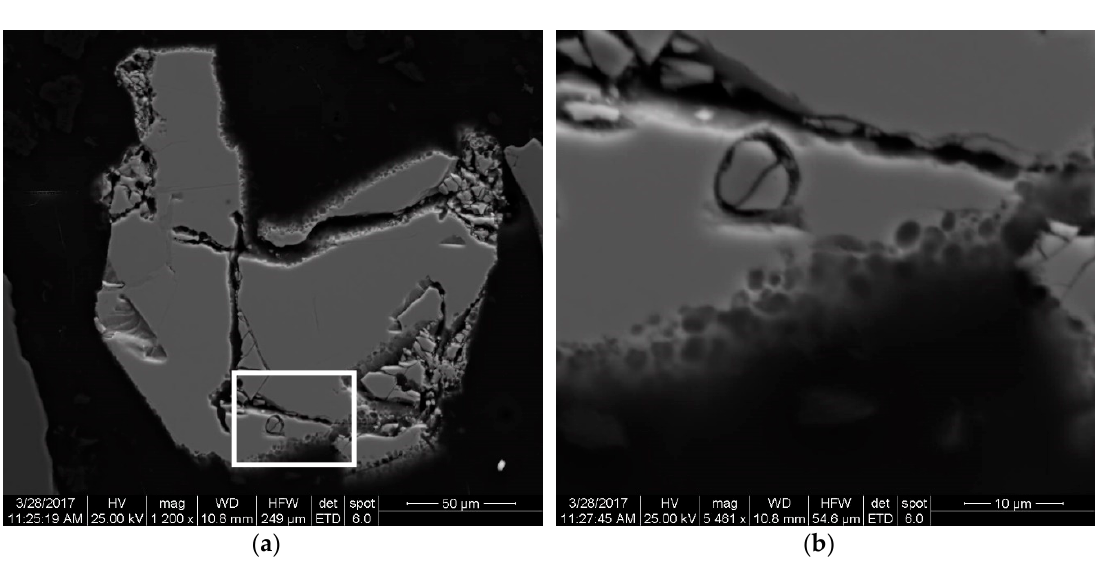
Figure 15. ( a ) Pentlandite grain showing pitting of the mineral surface and along cracks in the mineral grain. Secondary electron image: nitric acid treated concentrate. ( b ) Enlargement of area outlined in ( a ). Notice the pitted surface of the mineral grain as a result of the dissolution of the sulphide phase. Secondary electron image.